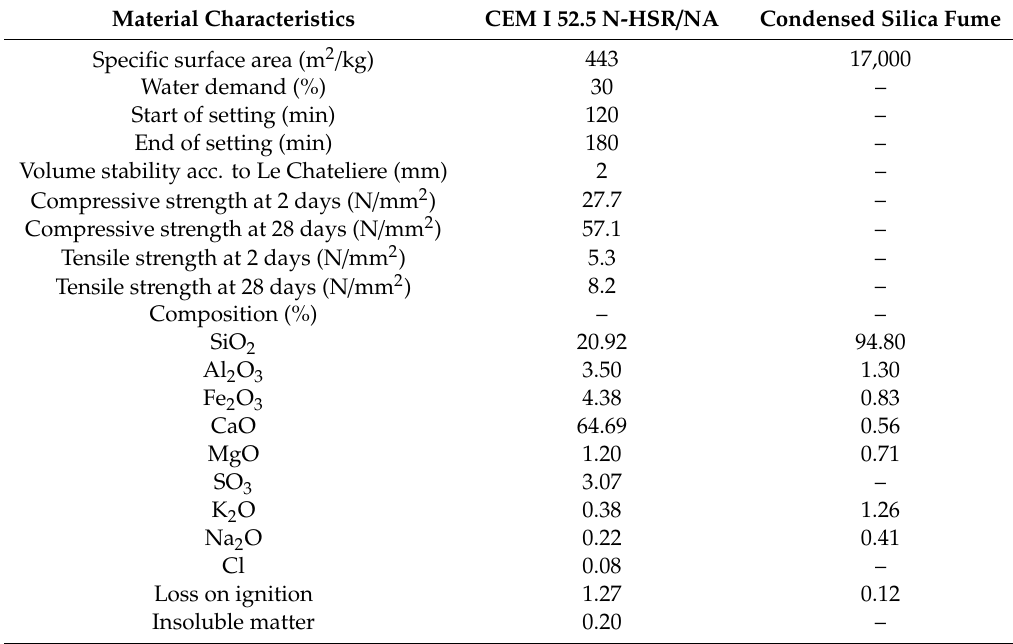
Table 1. Physical and chemical properties of the cement and condensed silica